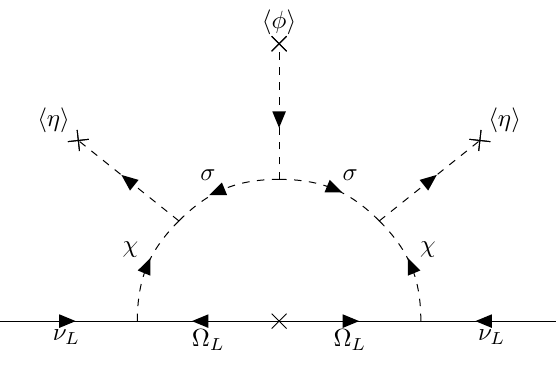
Figure 1 . Scotogenic loop for Majorana neutrino